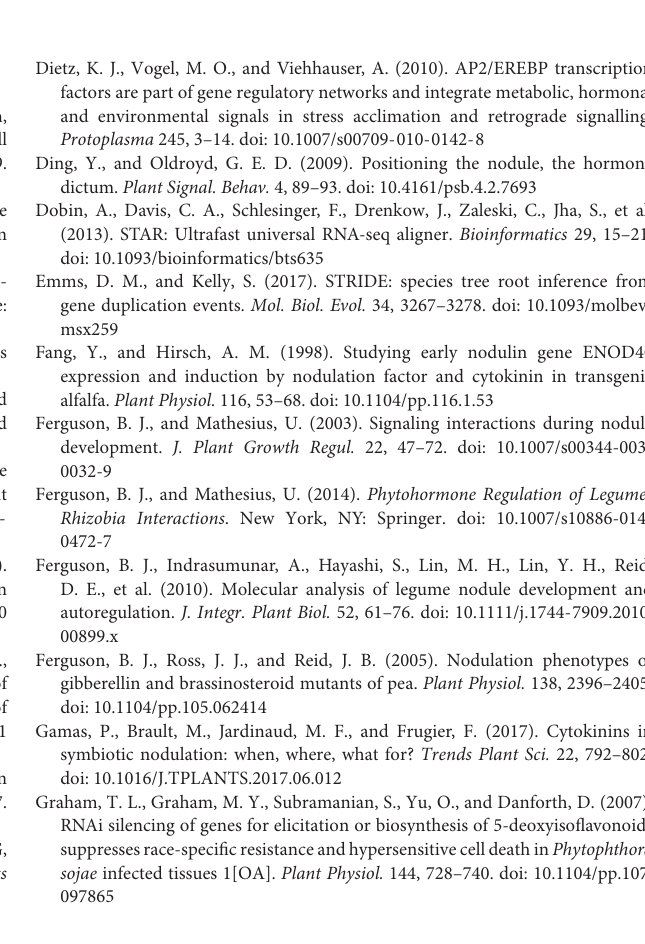
Supplementary Table 4 | Functional annotation of TRAP-seq using Mercator4. Supplementary Table 5 | Primer used for this